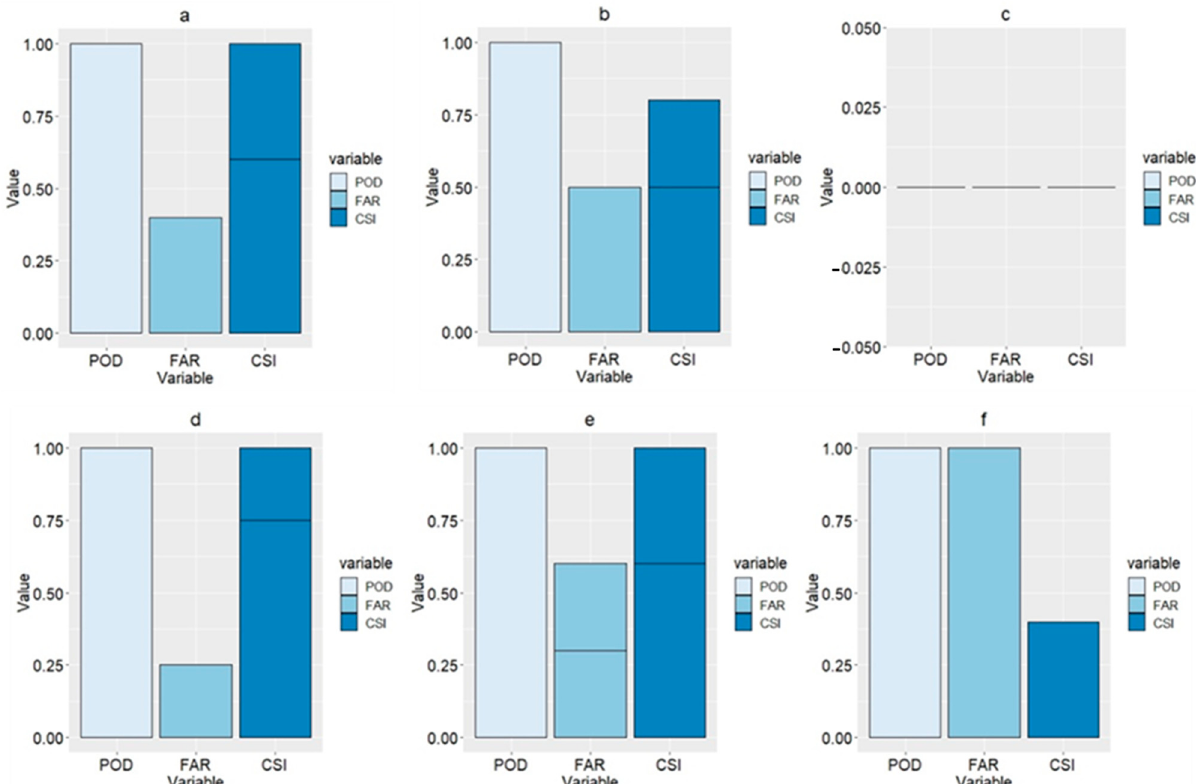
Figure 5. Bar plots of Probability of Detection (POD), False Alarm Rate (FAR), and Critical Success Index (CSI) results of the TMPA and IMERG at three different thresholds (0.1, 1, and 10) using data from all mentioned events. ( a ), ( b ), and ( c ) represent the thresholds of 0.1, 1, and 10 for the TMPA data, respectively, ( d ), ( e ), and ( f ) represent the thresholds of 0.1, 1, and 10 for the IMERG data.